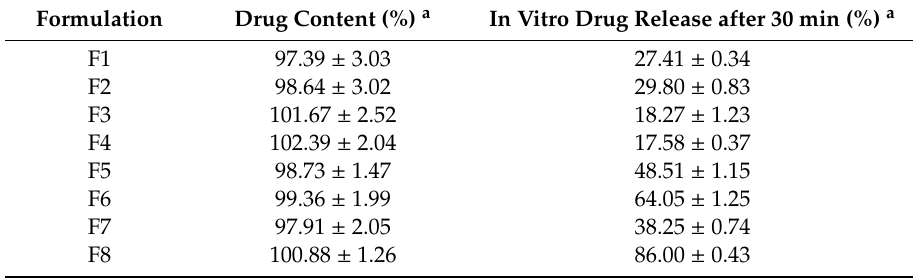
Table 2. Results of drug content and in vitro drug-release profile (at 30 min) for di ff erent formulations. Formulation Drug Content (%) a In Vitro Drug Release after 30 min (%) a